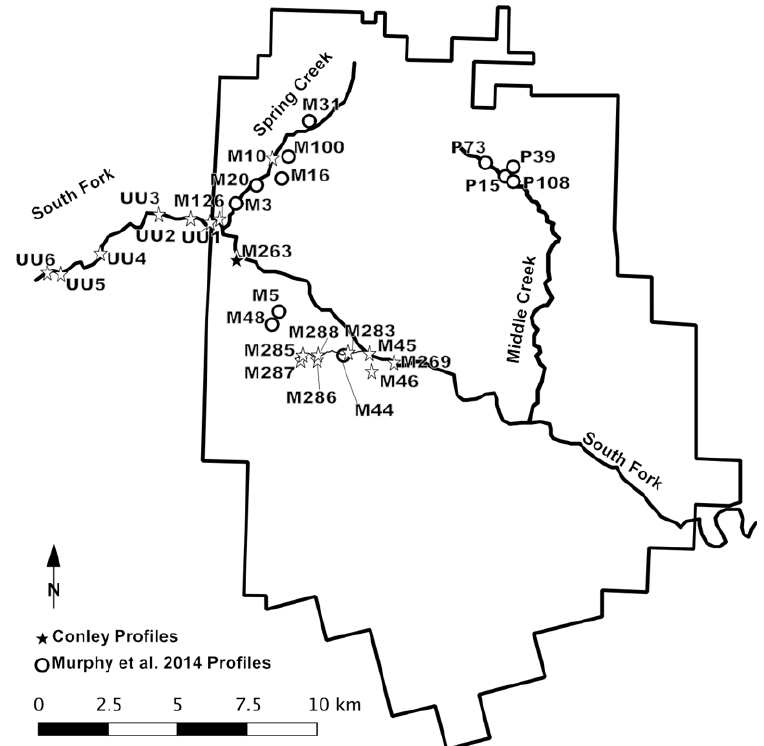
Figure 2. The Post research area and the location of soil profile localities from the current study (Conley profiles) and that of Murphy et al. (2014) along the South Fork River and its tributaries.